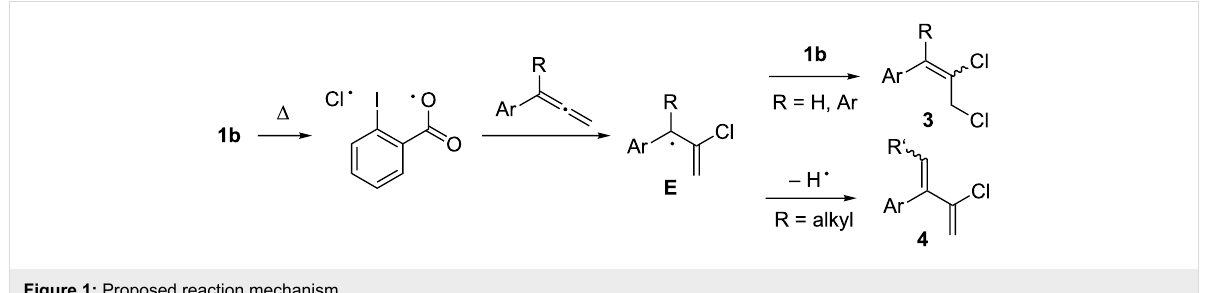
Figure 1: Proposed reaction mechanism.